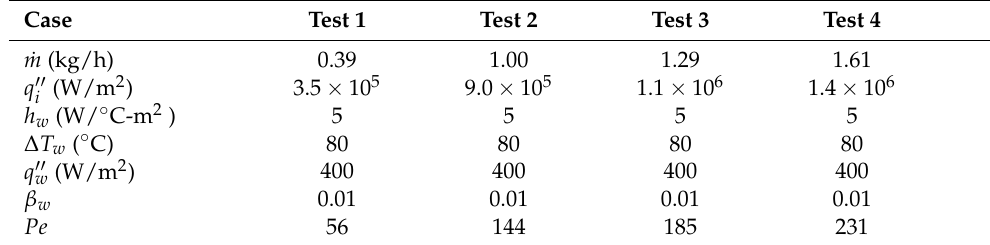
Table 2. Parameter values for the experimental